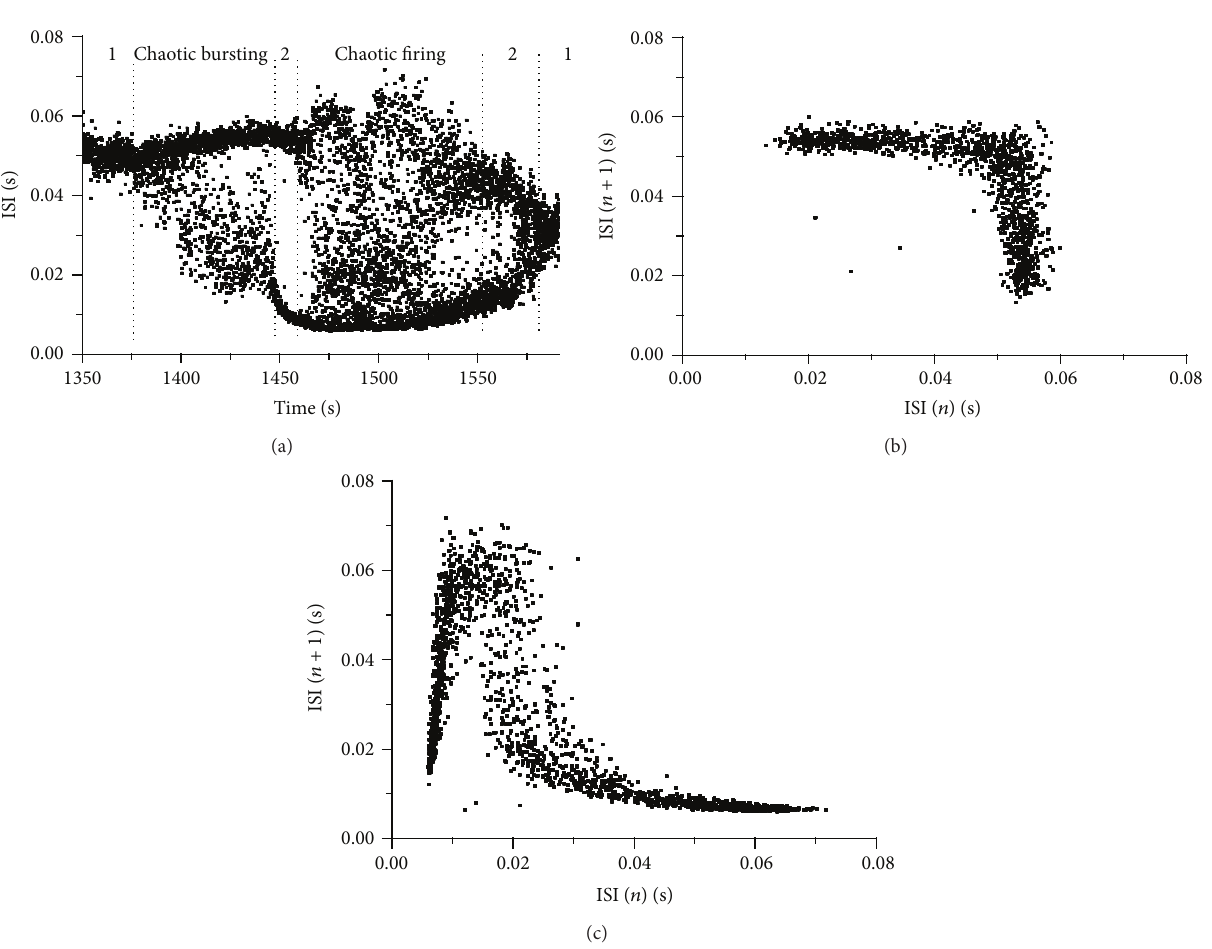
. (a) Bifurcation scenario o